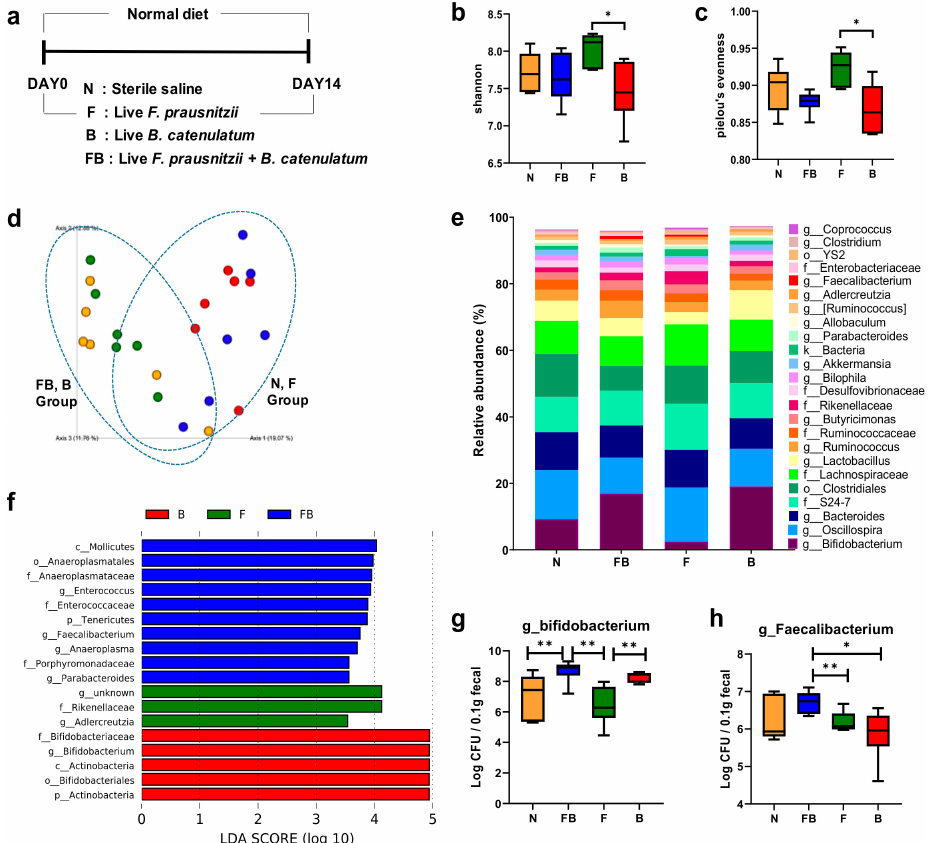
Figure 4. Fecal microbial composition in normal C57B6 mice fed F. prausnitzii and B. catenulatum . The microbiome was analyzed in mouse stool samples (6 mice per group). The mice were administered live bacteria or saline for 14 d ( a ). The alpha-diversity indices of microbial community richness and evenness are shown in ( b ) and ( c ). The beta-diversity based on the Bray-Curtis distance is shown in ( d ). The average relative abundance at the genus level (taxa with relative abundance > 0.5%) is shown in ( e ). Significantly di ff erent taxa in the B (red), F (green), and FB (blue) groups, determined by LEfSe analysis (threshold > 2.0), are shown in ( f ). The abundance of F. prausnitzii ( g ) and Bifidobacterium ( h ) in the feces was detected by RT-qPCR. Statistically significant di ff erences are shown (* p < 0.05, ** p < 0.01). N, normal mouse; FB, mice administered F. prausnitzii (1 × 10 9 CFU / mL) and B. catenulatum (1 × 10 9 CFU / mL); F, mice administered F. prausnitzii (1 × 10 9 CFU / mL); B, mice administered B. catenulatum (1 × 10 9 CFU /